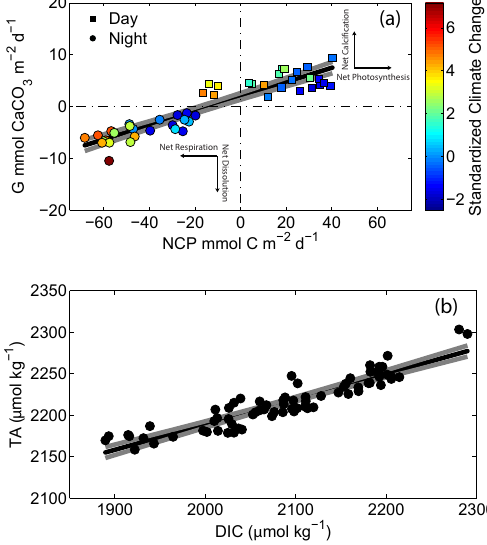
Figure 4. (a) Calculated G and NCP rates for all treatment aquaria. Squares are data collected during light (day) conditions and cir- cles represent data collected during dark (night) conditions, and the color represents standardized climate change (color bar). There is a strong positive relationship between G and NCP ( y = 0.14 x + 1.9, p <0.0001, R 2 = 0.85). Negative and positive y values are net dis- solution and net calcification, respectively; negative and positive x values are net respiration and net photosynthesis, respectively. (b) TA versus DIC: There is a strong positive relationship between TA and DIC ( y = 0.31 x + 1577.4, p <0.0001, R 2 = 0.85). Black and gray lines represent the best-fit line and 95% confidence inter- vals, respectively. As expected, the slope of TA versus DIC (0.31) is approximately twice that of G versus NCP (0.14). with standardized climate change (Table 2; Fig. 3c), sug- gesting that joint increases in ocean p CO 2 and temperature will increase nighttime dissolution of coral rubble. Lastly, G net had a strong negative relationship with standardized cli- mate change (Table 2; Fig. 3e), and the rubble community switched from net calcification to net dissolution at an in- crease in p CO 2 and temperature of 271 µatm and 0.75 ◦ C, respectively. Standardized climate change was also a signifi- cant predictor of NCP: day, night, and net NCP rates all de- clined with standardized climate change (Table 2; Fig. 3b, d, f). Net ecosystem calcification increased with net commu- In general, communities were net photosynthesizing and net calcifying during the day (Fig. 4a: squares in the upper right quadrant) and were net respiring and net dissolving at night (Fig. 4a: circles in the lower left quadrant). The exceptions were communities in the most extreme temperature– p CO 2 treatment: these communities were net respiring during the day while holding a positive, yet very low, calcification rate (Fig. 4a: squares in the upper left